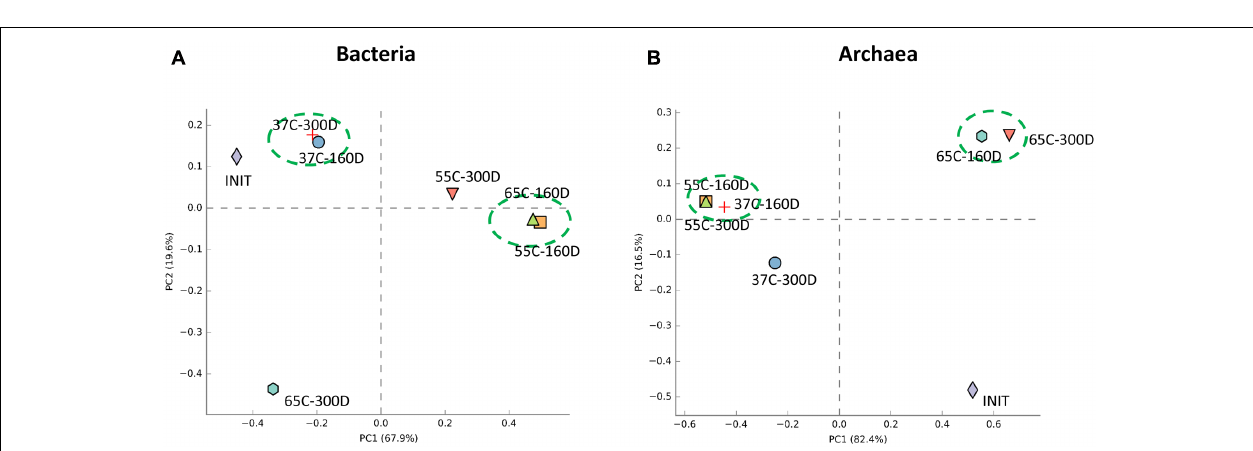
FIGURE 5 | Distribution of taxonomic groups in different temperature culture microcosms with 160 (A,C) and 300 (B,D) days incubation. The percentage of bacterial (A,B) and archaeal (C,D) families associated with each microcosm is visualized in ternary plots. The position in triangle indicates the relative abundance of each taxon among the three cultured microcosms, the size of the circle represents the relative abundance of taxa.